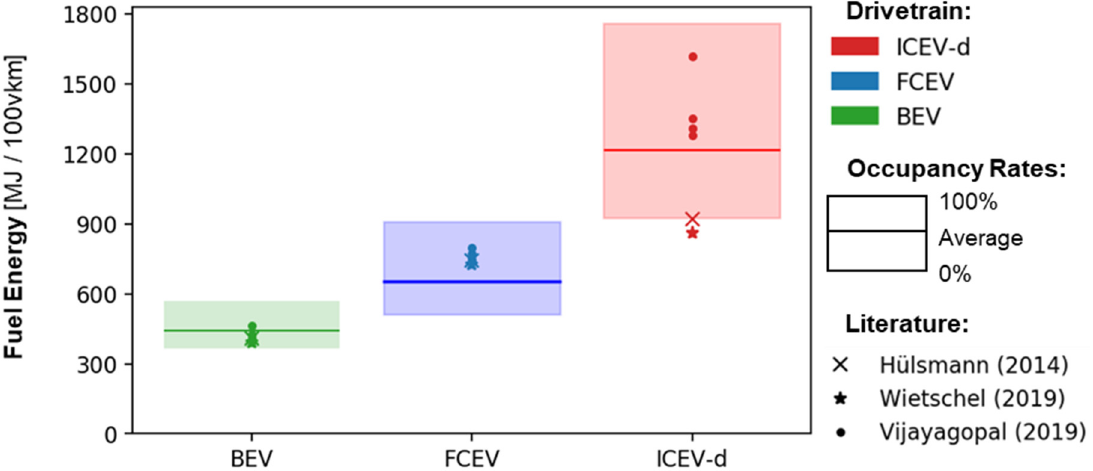
Figure 6. Model vs. literature energy demand for large trucks [59,61,62]. Solid lines represent the fuel energy demand for the average occupancy rate. The shaded area represents the energy demand for varying occupancy rates of between 0% and 100%, according to the model.